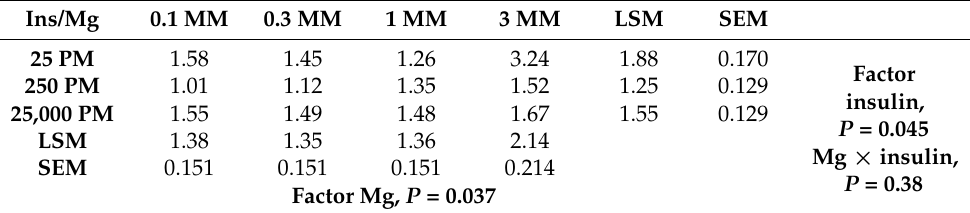
Table 1. Least square means (LSM) of the glycerol-3-phosphate dehydrogenase (GPDH) activity in bovine adipocytes from five animals at various insulin (Ins in pM) and magnesium (Mg in mM) concentrations after 7 days of